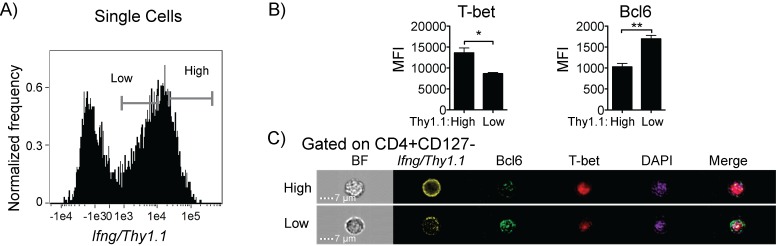
Level of T-bet in the nucleus correlates with Ifng/Thy1.1 expression.
Ifng/Thy1.1 BAC-In reporter mice were infected with P. chabaudi and splenocytes were analyzed on day 7 post-infection. After positive selection of Thy1.1 cells, cells were stained for surface CD4, CD127, and Thy1.1 (yellow), followed by intracellular staining for Bcl6 (green) and T-bet (red). Just before analysis, nuclei are stained with DAPI (purple), and analyzed by imaging flow cytometry. (A) Histogram showing Ifng/Thy1.1 expression is gated on single focused cells. Cells were gated on CD4+CD127- Teff and (B) expression of Bcl6 and T-bet was measured within Ifng/Thy1.1 high and low gates as shown in (A). (C) Representative images of individual cells from imaging flow cytometry. Bright Field (BF) and DAPI/Bcl-6/T-bet merged images are shown. Statistical significance was obtained using Students t test. Error bar represents SEM; ★
p < 0.05, ★★
p < 0.01.